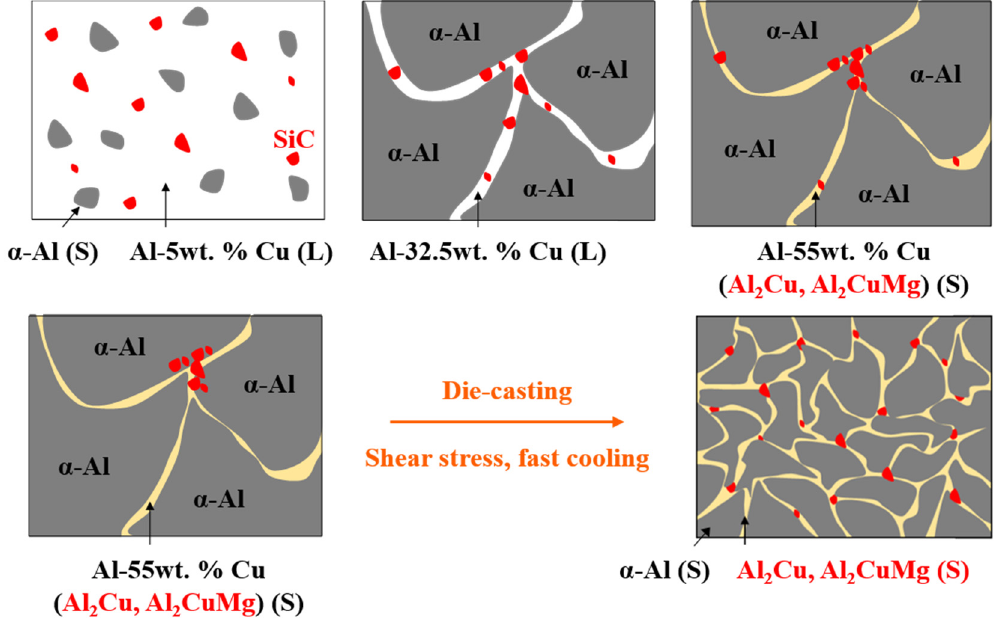
Figure 3. Schematic diagram of solidification behavior of SiC/AA2024 AMCs. The grain size was observed by electron backscatter diffraction (EBSD) analysis (Fig- ure 4) to determine the average grain size of SC- and DC-processed 9 vol.% SiC-reinforced specimens. In Figure 4, the black color indicates SiC particles; the average grain sizes are 68.06 μ m (SC, Figure 4a) and 17.67 μ m (DC, Figure 4b), respectively. It is confirmed that the average grain size decreases by about 75% due to grain refinement from the fast cool- ing rate of the DC process. The addition of SiC particles and the fast cooling rate during the DC process increase the grain-refinement effect of the SiC/AA2024 composite, which might contribute to strengthening of the composite.